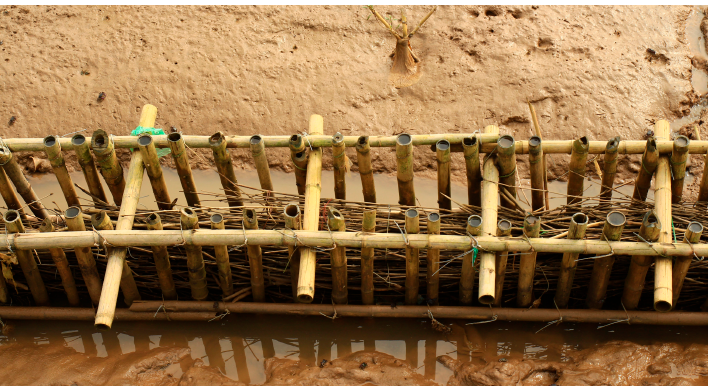
Figure 1. Wooden fences in the field [6]. The construction includes the frame (two rows of 6–8 cm diameter bamboo poles) and the inner part (a bunch of branches of 1–2 cm diameter bamboo reeds). Reproduced with permission from Dao et al. (2018), Journal of Coastal Research; published by BioOne, 2018.